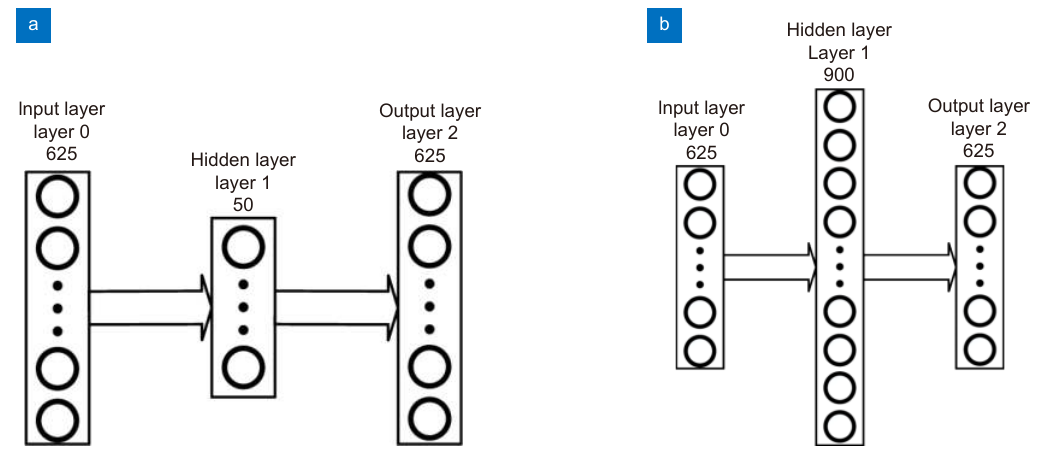
Fig. 4 | ( a ) The classification network similar to CoG method for spot detection with 50 hidden layer neurons named as SHNN-50. ( b ) The classi- fication network with 900 hidden layer neurons named as SHNN-900. The input is the flattened subaperture image (25×25) and the output is a kind of classification in 625 classes, the same as the number of pixels indicating the potential center of the spot. Figure reproduced from ref. 73 , Optical Society of America.